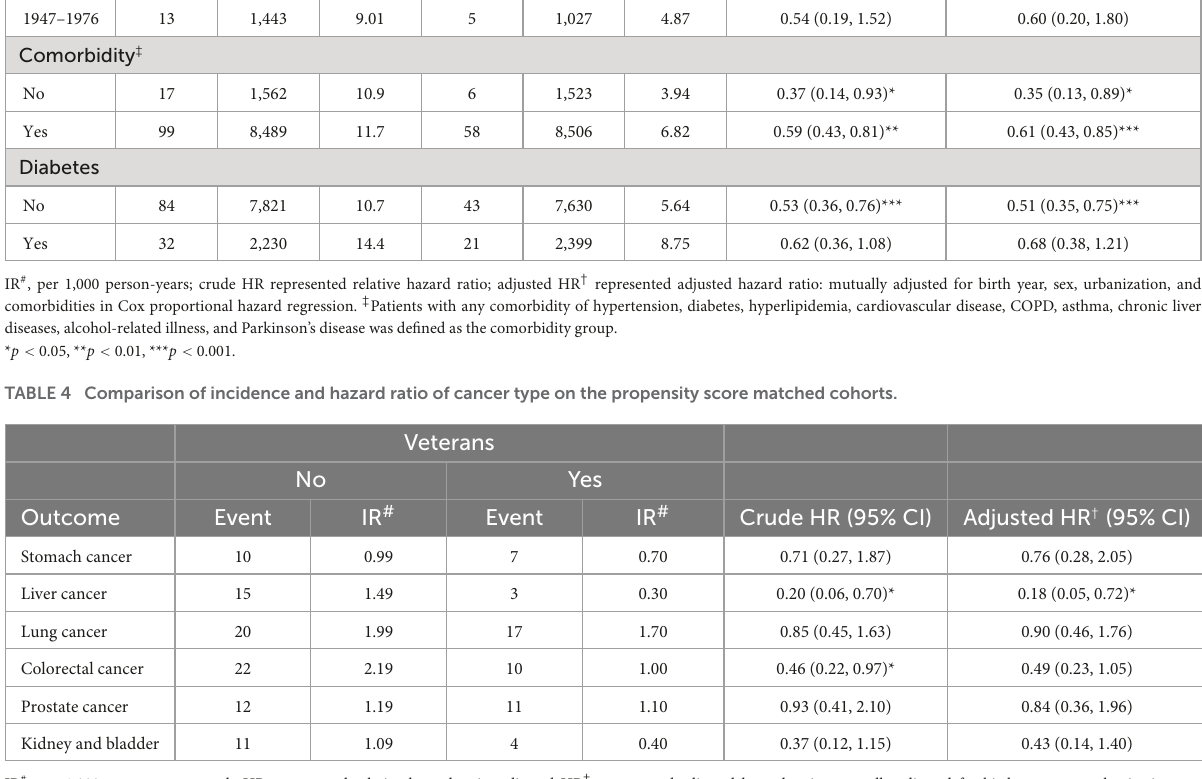
Lung cancer Colorectal cancer Prostate cancer